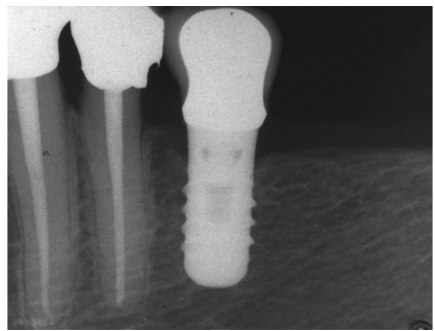
Figure 3: Single-tooth fixed prosthesis supported by a short implant (4 . 1 × 8 mm): 12 years after loading. Periapical radiograph.